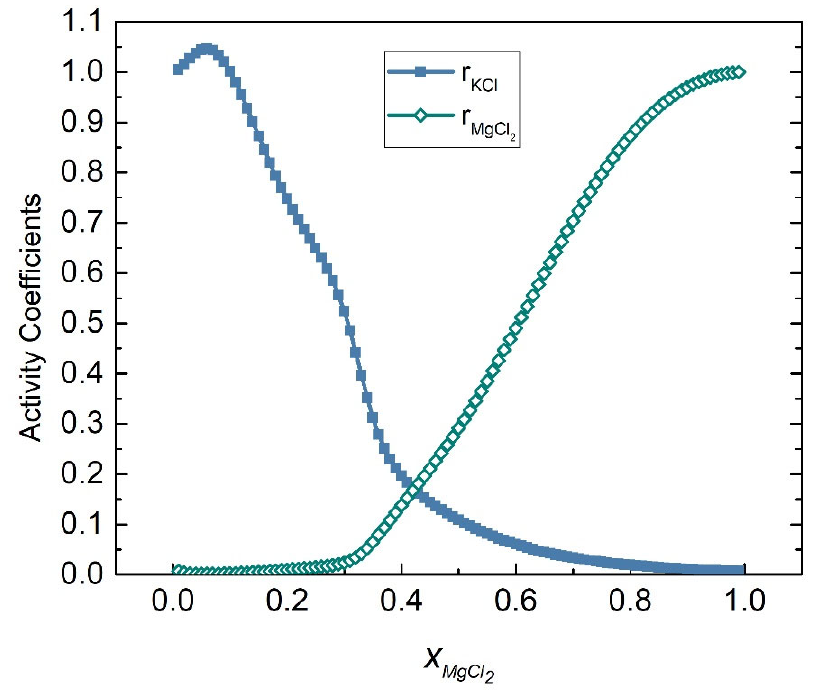
Figure 15. Calculated activity coefficients of each element of the KCl ‐ MgCl 2 system (998 K).